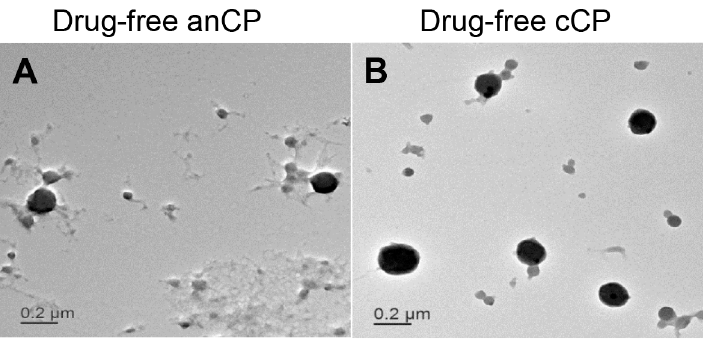
Figure 1. Transmission electron microscope (TEM) images of drug-free starch-chitosan polyplexes stained by 0.5% phosphotungstic acid solution: ( A ) drug-free anCP; and ( B ) drug-free cCP.